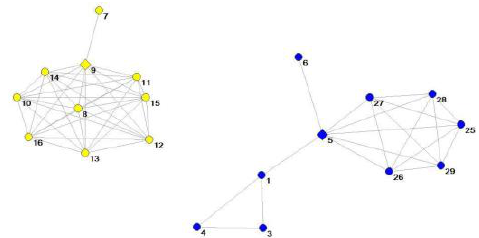
Fig.8. The deconstruction of Marc's network, stage